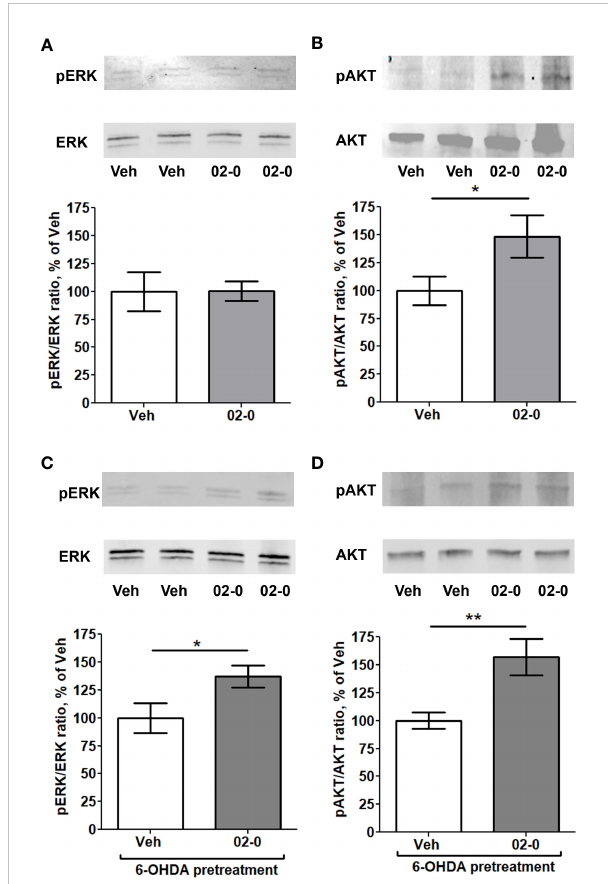
FIGURE 3 Activation of intracellular signaling pathways by 02-0 in SH-SY5Y cells (A) Western blot for ERK 1/2 and pERK 1/2 in SH-SY5Y cells after 10 min treatment with Veh or 100 nM 02-0,